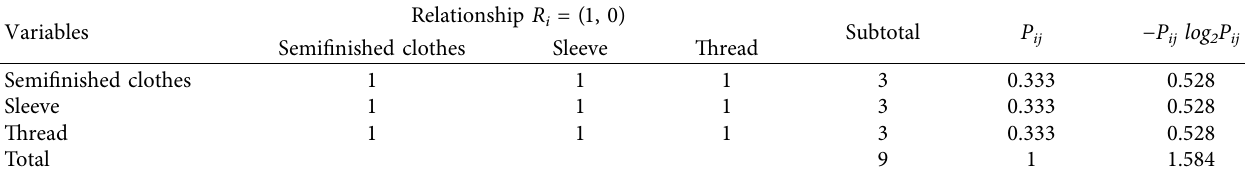
Table 8: Perception complexity result of product information variables.